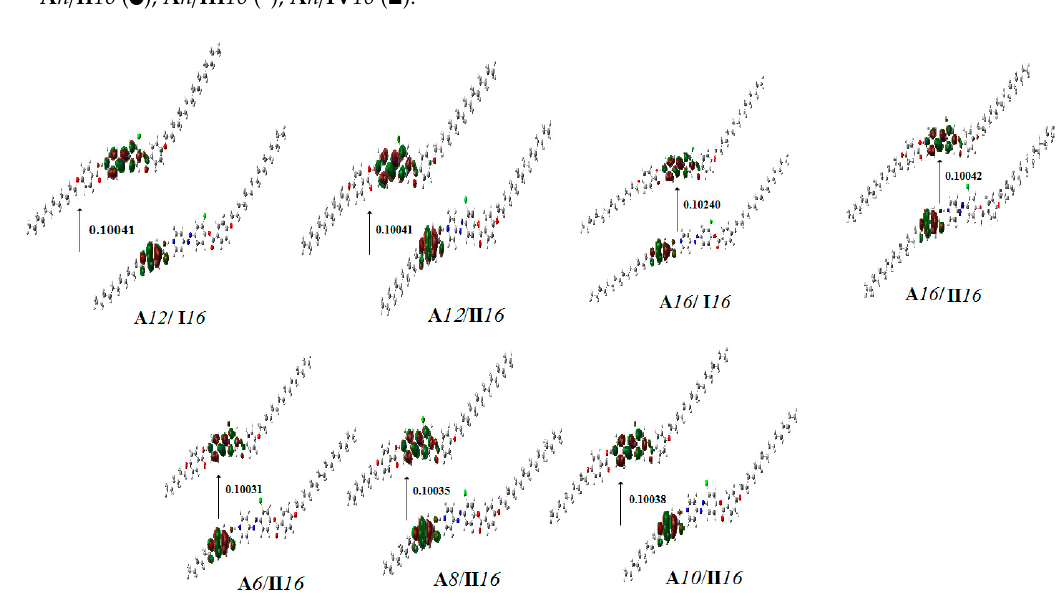
Figure 10. The calculated ground state isodensity surface plots for frontier molecular orbitals of A 12 / I 16 , A 16 / I 16 and A n / II m. Table 4. Molecular orbital energies and global softness ( S ) of A 12 / I 16 , A 16 / I 16 and A n / II m. Compound